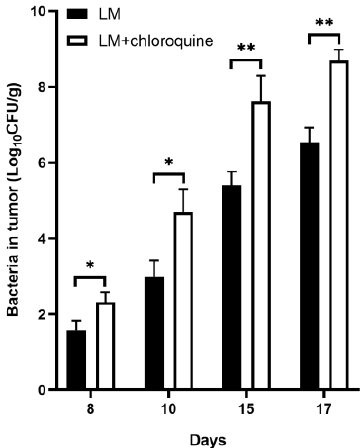
Figure 6. Combined therapy of LM + CQ enhanced bacterial tumor-targeting ability. LM was intraperitoneally infected with a tumor-bearing mice model ( n = 6 for each group). On day 1 and day 3, after two intraperitoneal doses, the mice in each experimental group were euthanized and the bacterial load in the tumor tissue was determined. The y-axis represents the logarithm of viable bacterial CFU to base 10 in the tumors (* p < 0.05, ** p <